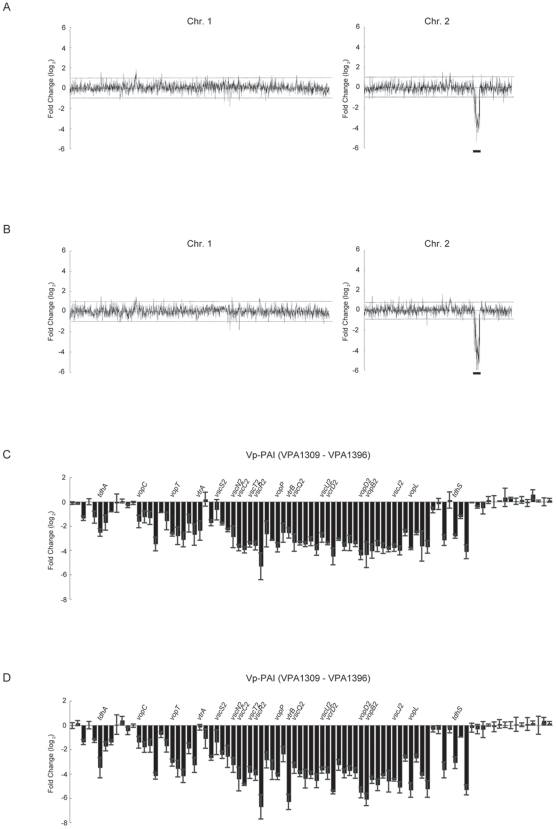
Whole-genome transcriptional profiling of vtrA and vtrB deletion strain.Genome-wide transcript analysis of the VtrA and VtrB regulons is shown. Gene expression was determined by comparing cDNA generated from WTΔvtrA (A) or WTΔvtrB (B) in exponential phase grown in LB medium with 0.5% NaCl with that from the WT strain. The Vp-PAI region is indicated by a bold line. Effect of the vtrA (C) or vtrB (D) deletion on expression of genes located within Vp-PAI (vpa1309-vpa1396). Representative gene functions are indicated at the top.